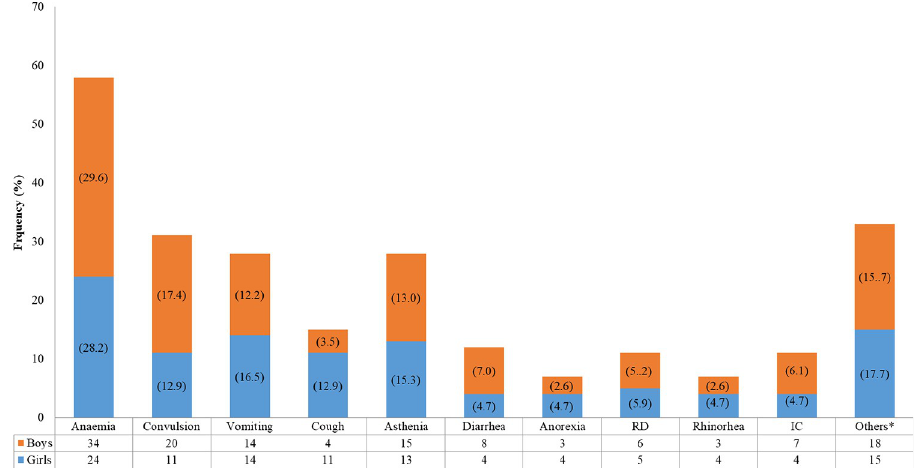
Fig 2. Frequency of reasons for consultation according to gender. Note. RD, Respiratory Distress; IC, impaired consciousness; Others � , headache + prostration + weight loss + abdominal pain + joint pain + rashes + ingestion of